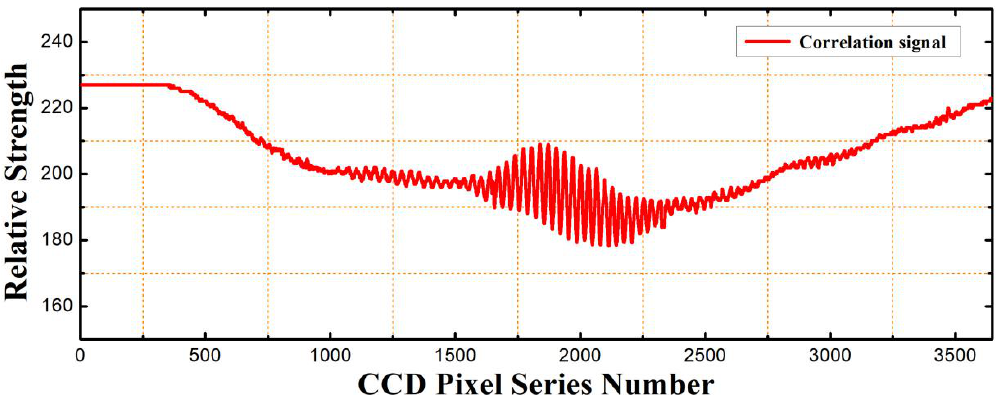
Figure 3. Typical correlation interferometric signal for a fiber-optic compound FP pressure sensor with a basal cavity length of 650 μm, and an initial air-cavity length of 81.873 μm under one standard atmosphere pressure. The air-gap optical wedge used is with a thickness range of 60~95 μm.